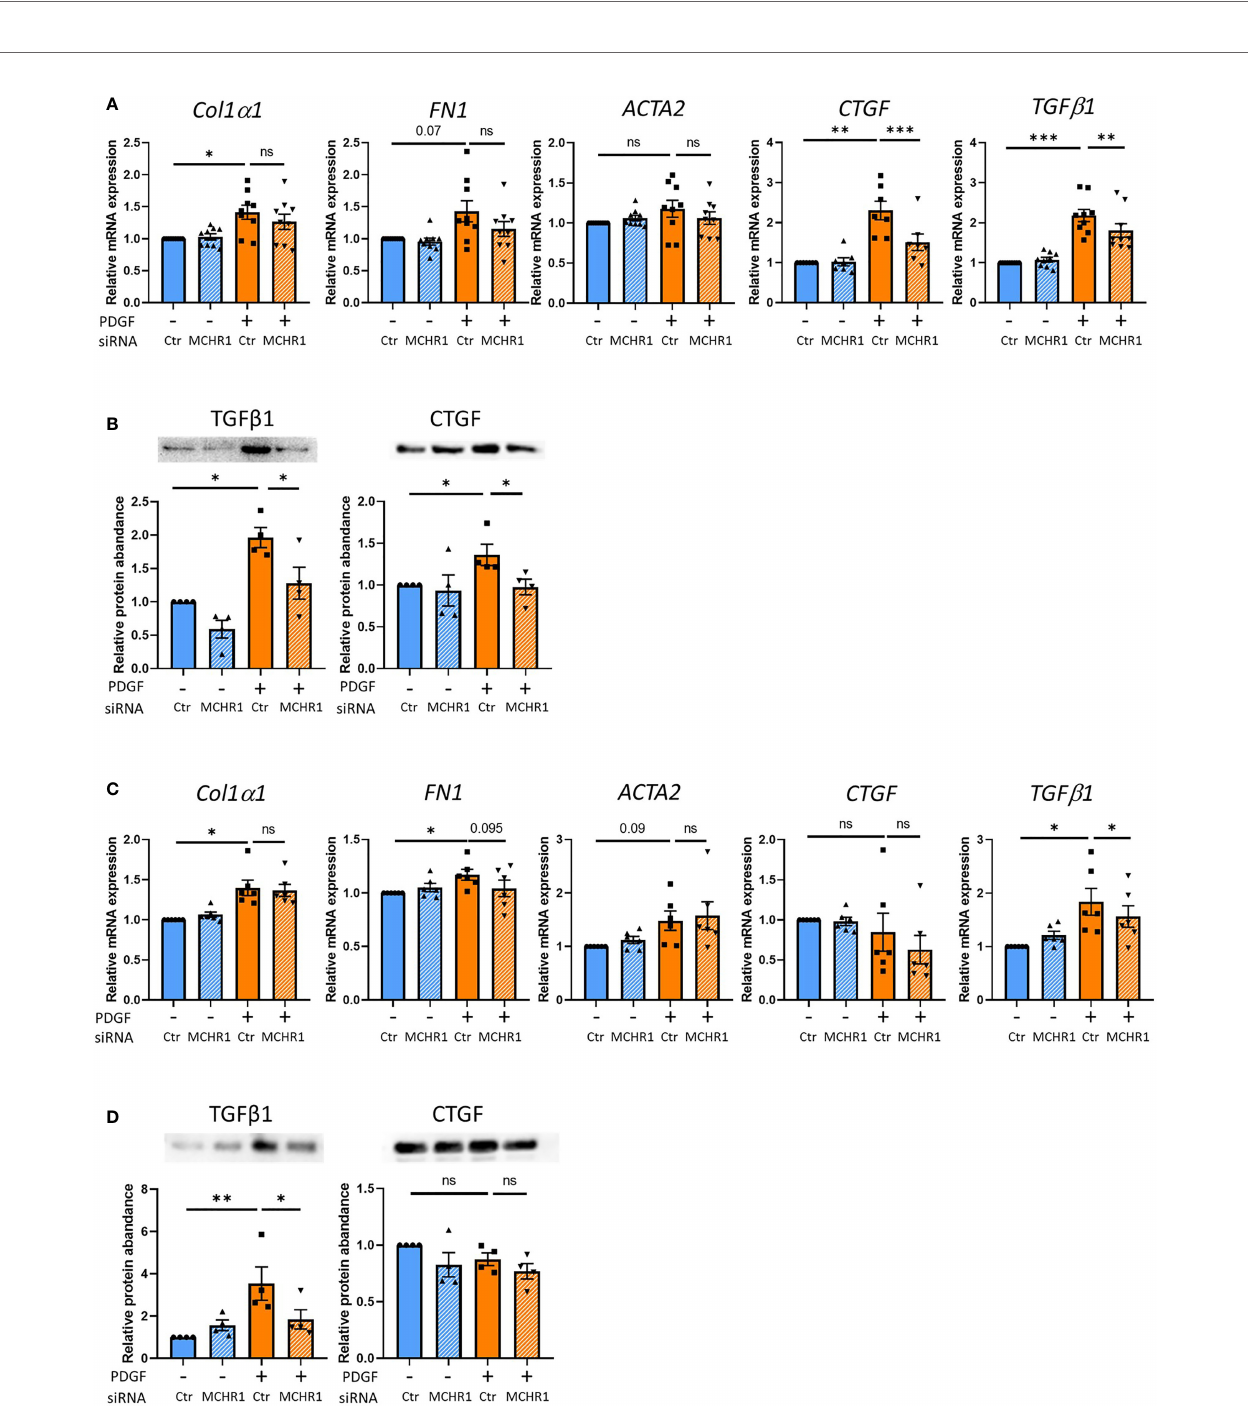
FIGURE 3 | Effect of MCHR1 silencing (siMCHR1) on fi brotic expression levels in NHDF and SSc dermal fi broblasts. NHDF were transfected with siMCHR1 for 72 hrs then stimulated with PDGF-BB (40ng/ml) for 6 hrs (n=6) and 24 hrs (n=9). SSc dermal fi broblasts were transfected with siMCHR1 for 48 hrs then stimulated with PDGFBB (40ng/ml) for 6 hrs (n=6) and 24 hrs (n=6). Transfection ef fi cacy is shown in Supplementary Figure 5 . (A) Effects of MCHR1 silencing on the expression levels of fi brotic genes in NHDF treated with PDGF-BB or vehicle. (B) Quanti fi cation of TGF b 1 and CTGF protein abundance in the conditioned media of NHDF transfected with siMCHR1 and treated with PDGF-BB (n=4). Representative immunoblots are shown. (C) Effects of MCHR1 silencing on the expression levels of fi brotic genes in SSc dermal fi broblasts treated with PDGF-BB or vehicle. (D) Quanti fi cation of CTGF and TGF b 1 protein abundance in the conditioned media of SSc dermal fi broblasts transfected with siMCHR1 and treated with PDGF-BB (n=4). Representative immunoblots are shown. *P < 0.05, **P < 0.01, ***P < 0.001, ns, not signi fi cant, error bars =